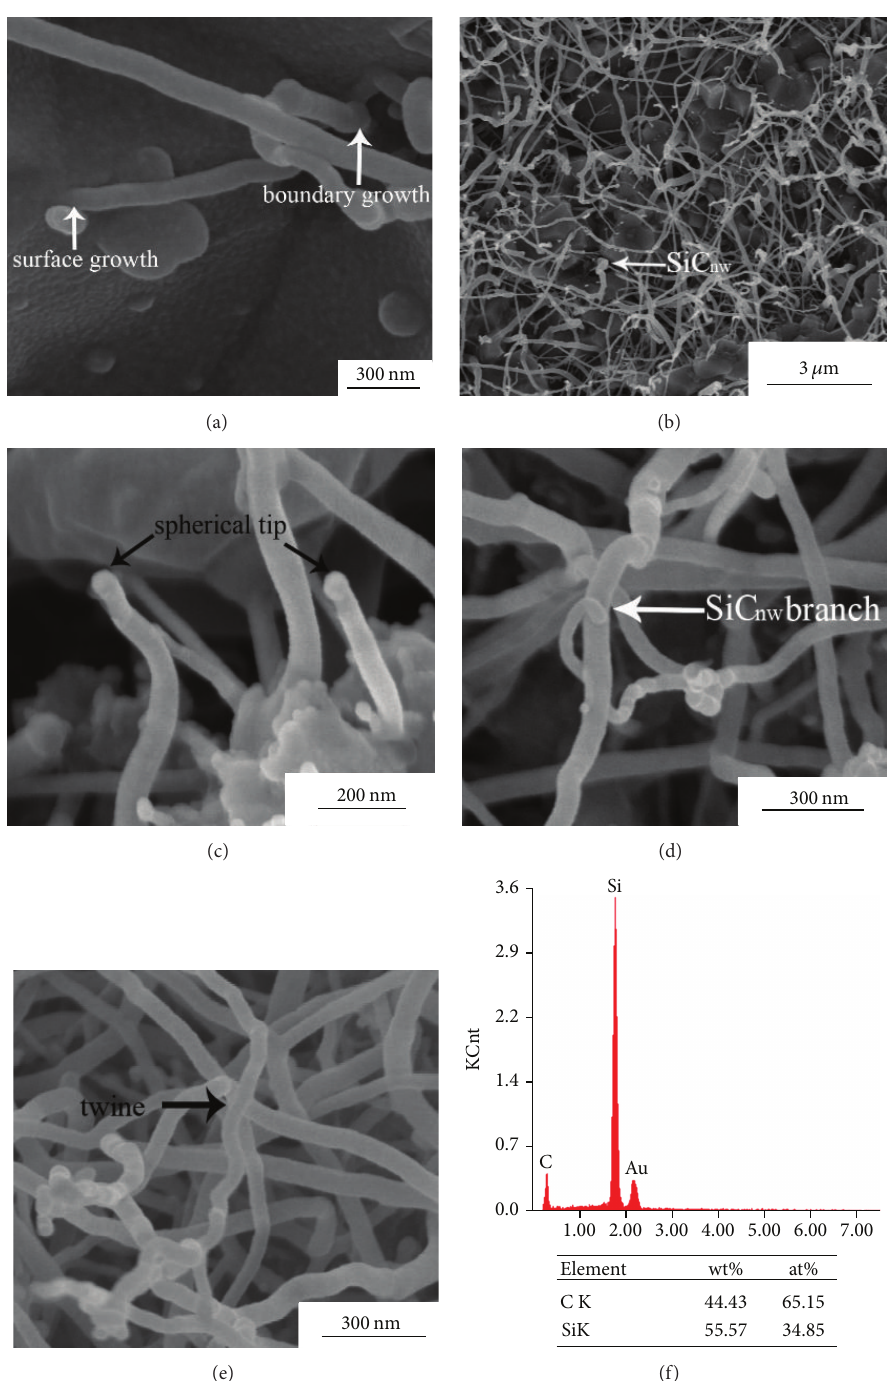
Figure 4: SEM of fracture surface for AM60 specimen, (a), (b), (c), (d), and (e) represented fracture surface and (f) represented the spot energy